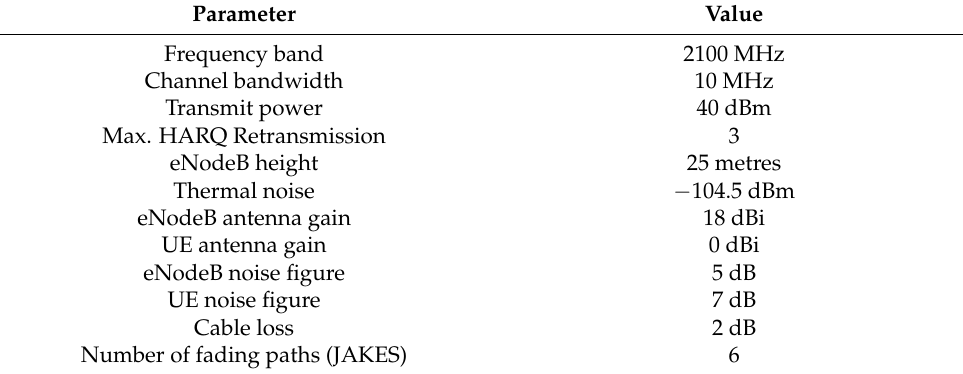
Table 3. LTE-specific